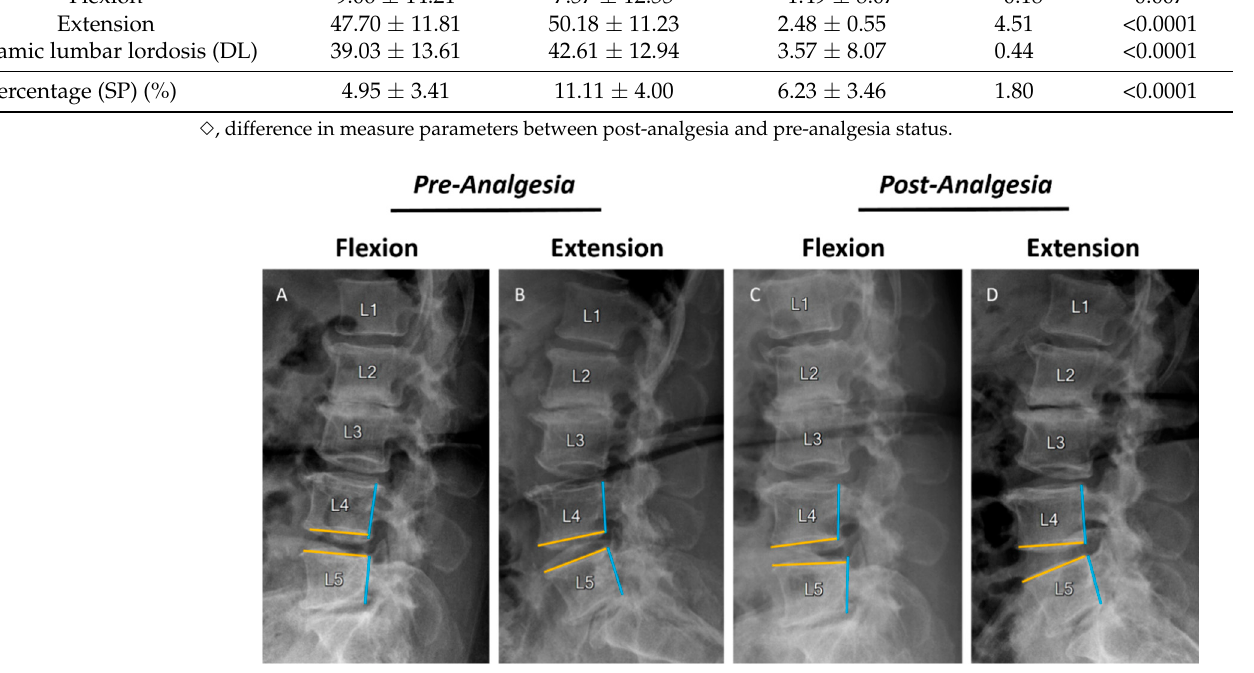
Figure 2. Case demonstration of radiographic change after analgesia . The radiographs showed the effect of radiographic change after intramuscular ketorolac injection in a 57-year-old patient with chronic low back pain. ( A , B ) X-ray image of lumbar spine flexion and extension before analgesic treatment. L45 was identified as a stable motion segment ( L45, DA: 6°, DS: 0.5mm, SP: 1.2%) with minimal displacement and angulation. ( C , D ) X-ray images of lumbar spine flexion and extension after analgesic treatment. Both anterior displacement and segmental angulation at L45 were increased after analgesic treatment. (L45, DA: 25.4°, DS: 4.7 mm, SP: 12%). Unstable spondylolisthesis at L45 was identified after analgesic treatment (blue line: posterior walls of vertebra; yellow line: tangent line of endplates).